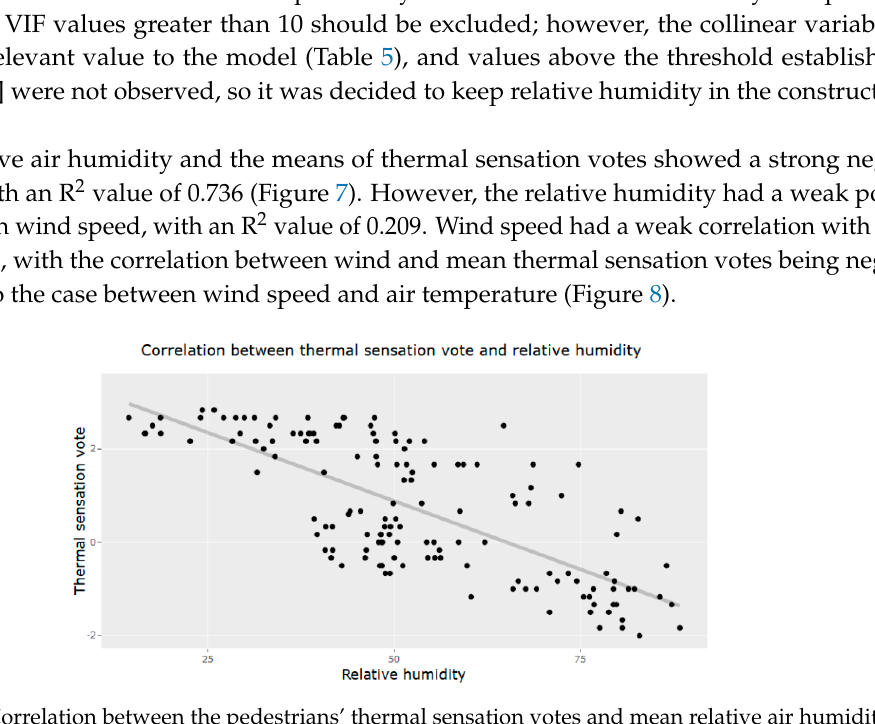
. Figure 8. Correlation between the pedestrians’ thermal sensation votes and mean wind speed in the two analysis periods (January and July 2016). The probability density function (PDF)—or density of a continuous random variable—was calculated for the means of the thermal sensation votes of the individuals interviewed during the entire study (winter and summer) as well as for mean air temperature, mean relative humidity and mean wind speed for that period. The PDF is a function that describes the relative probability of these random variables when taking a given value. Table 5 shows the results of the linear regressions performed for the mean values reached for the conditions surveyed during the study (summer and winter) to obtain the model.